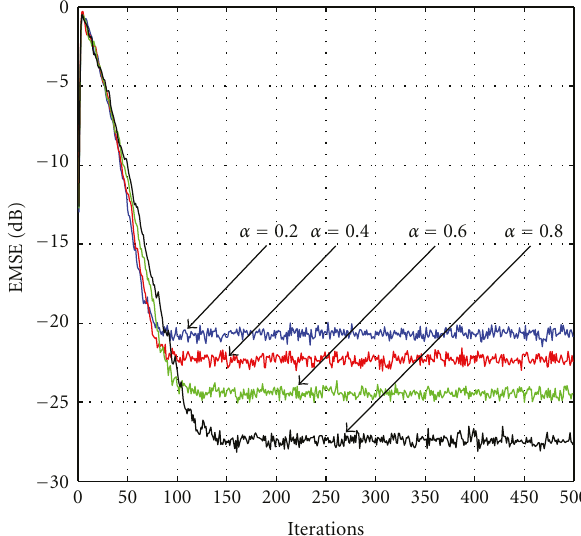
Figure 3: E ff ect of α on the learning curves of the proposed algorithm in a Laplacian noise environment scenario for p = 1.